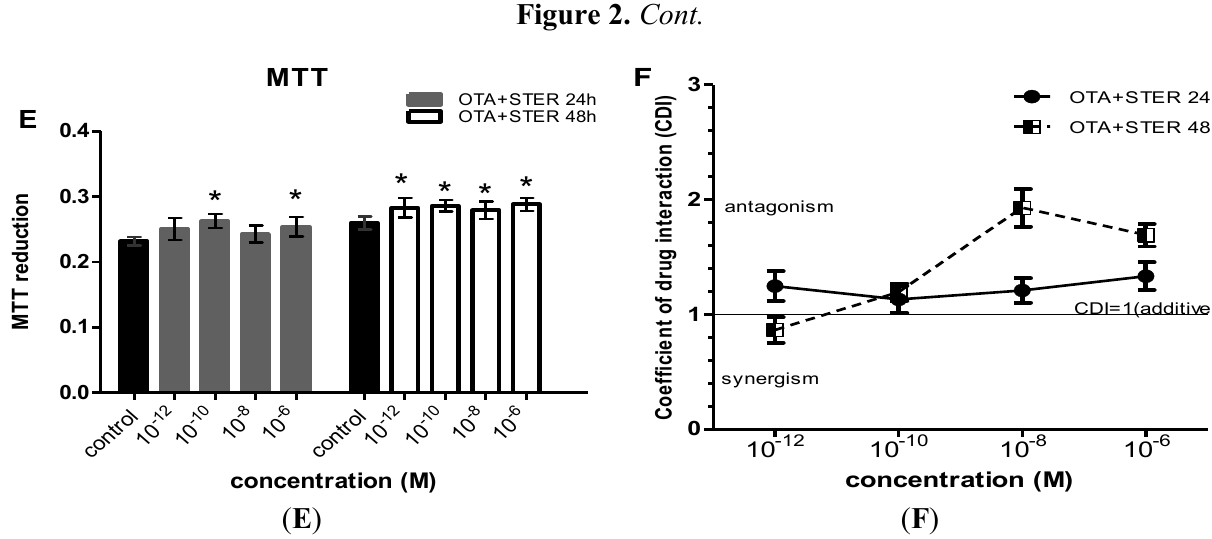
Figure. 3. Evaluation of MTT activity in Hep3B cells after co-administration of ( A ) CTN, OTA and STER for 24 and 48h; Bars represent mean values of every concentration at each time point, which was evaluated at three individual experiments, performing measurements at a number of 8-plicates each time (8-plicates, n = 3). Error bars give the standard error (SE) between the replicates (n = 3). The asterisks represent statistically significant differences over the respective vehicle-receiving cells (control) (* p < 0.01). CDI values (CDI = 1 CDI < 1 and CDI > 1, shows additive, synergic and antagonistic action respectively) after co-administration of ( B ) CTN, OTA and STER. Again error bars give the standard error (SE) between the replicates (n =